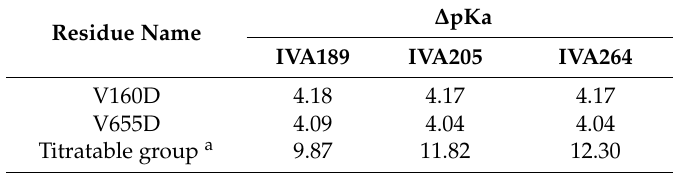
Table 4. Difference in pKa values ( ∆ pKa) between the parent laccase and evolved